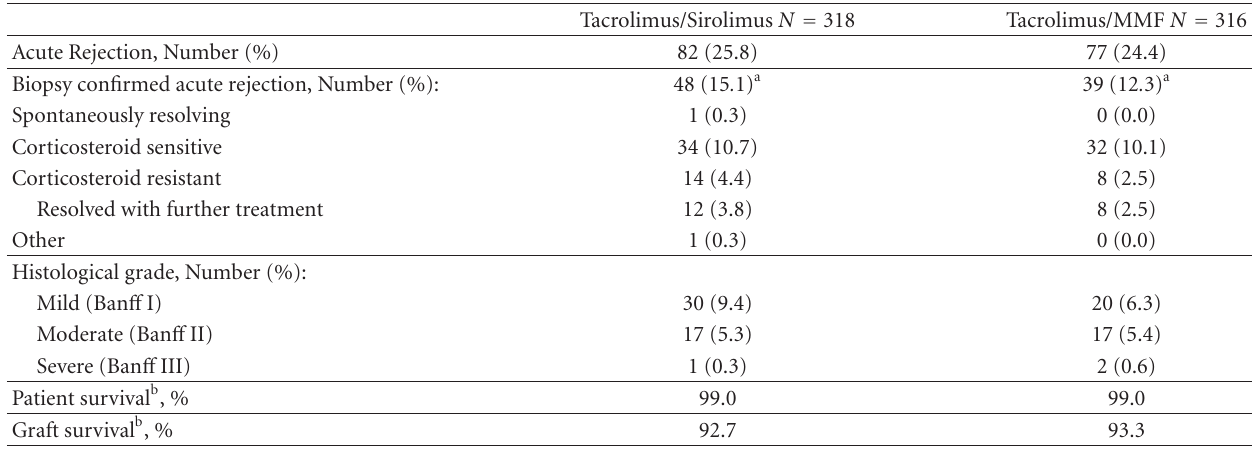
Table 3: Selected secondary